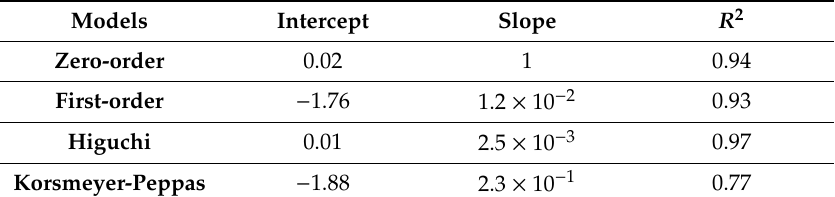
Table 1. Kinetic model elaboration of GS release from EL matrices incubated in static conditions in (pH